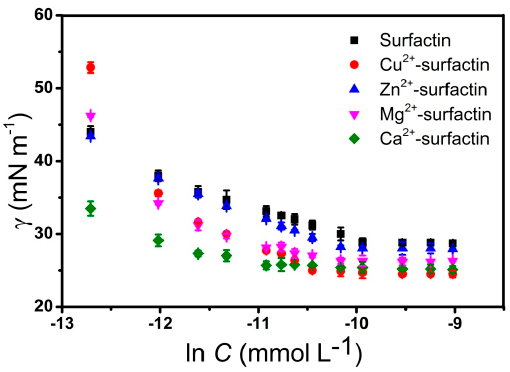
Figure 3. Surface tension profiles of surfactin and metal-surfactin complexes in Hepes buffer (pH 7.4) at 25 °C. The values represent the mean of triplicates ± SD.